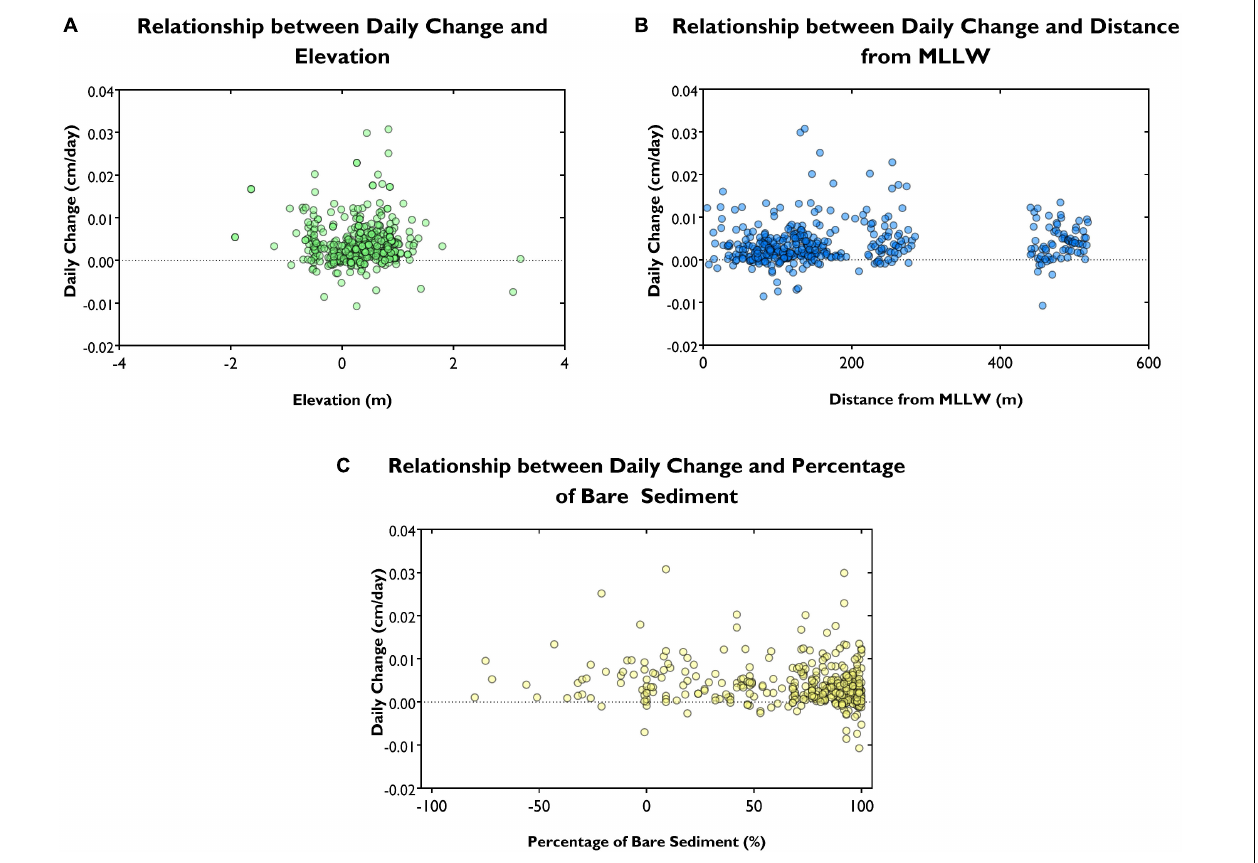
FIGURE 7 | The relationship between long term change and (A) elevation, (B) distance from MLLW and (C) percentage bare sediment.